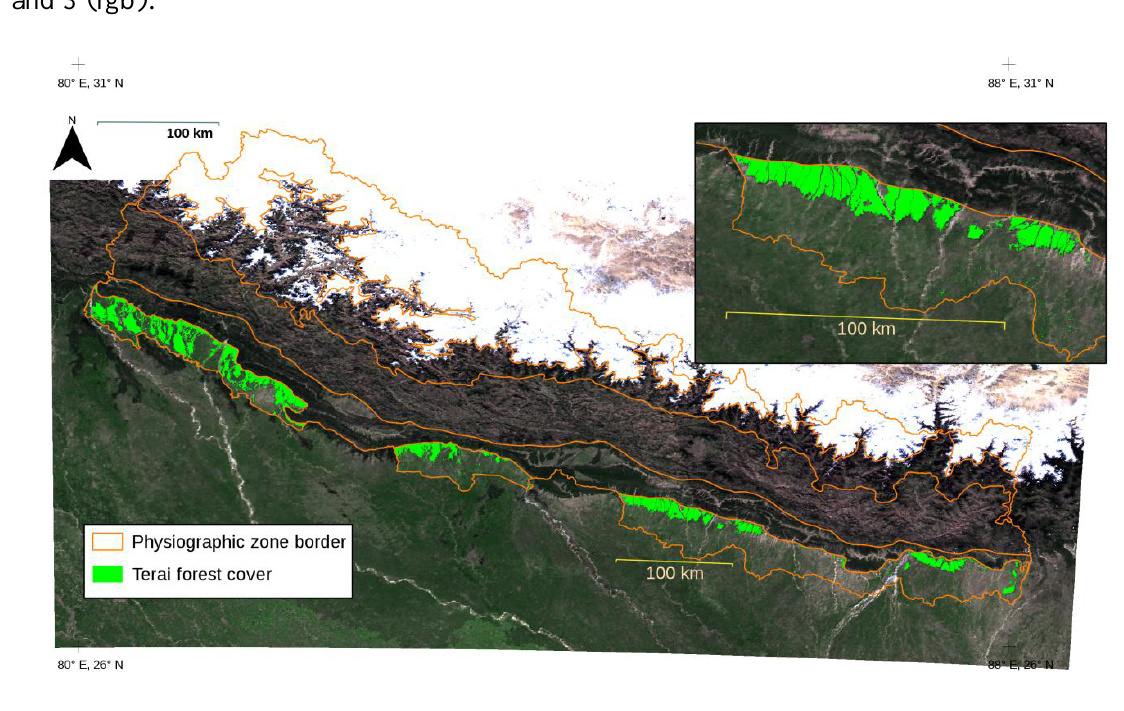
extreme observations, whereas the median of residuals is close to zero in all categories (Figure 6). Figure 5. A forest cover map (forest: bright green color) for the Terai physiograhic zone produced by the k -NN technique and overlaid on a composite of MODIS image bands 1, 4 and 3 (rgb).